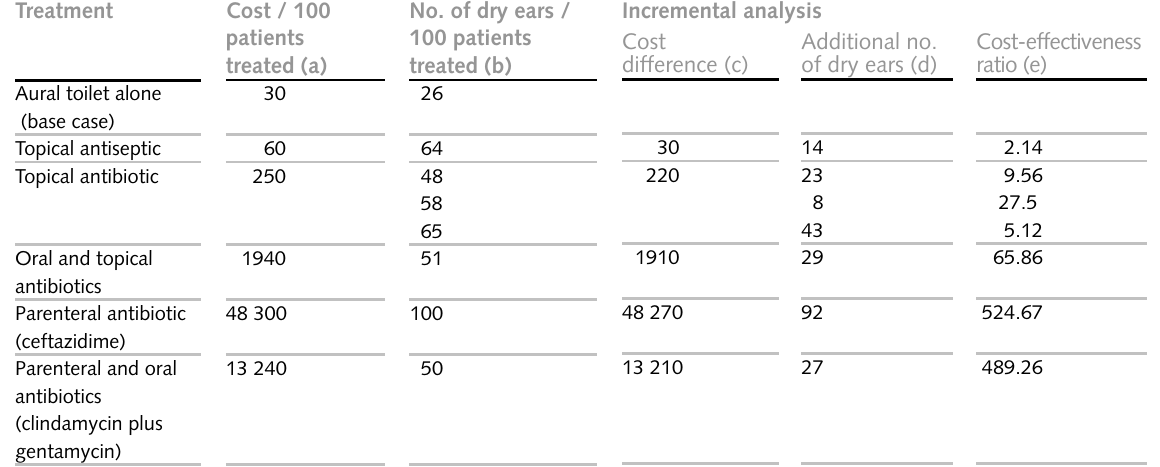
(b) Single or pooled event rates in the treatment arms of randomized controlled trials included in a meta-analysis. (c) Column a minus cost of aural toilet (US$ 30). (d) Risk differences reported in meta-analyses or individual trials; percentages are converted to n / 100. (e) Column c divided by column